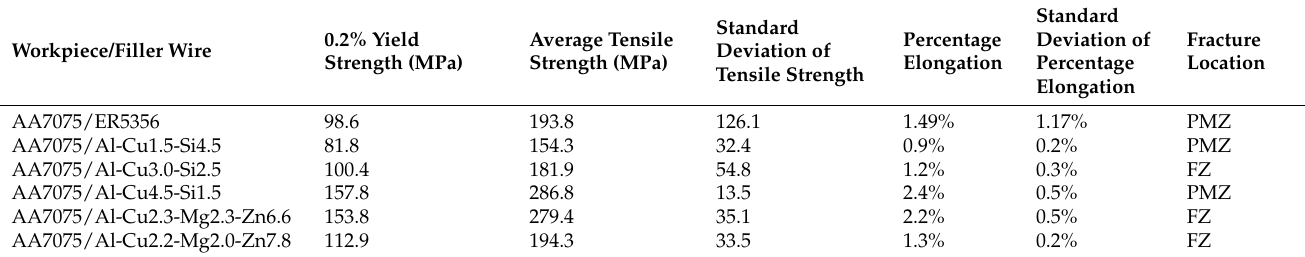
Table 3. Tensile test results.